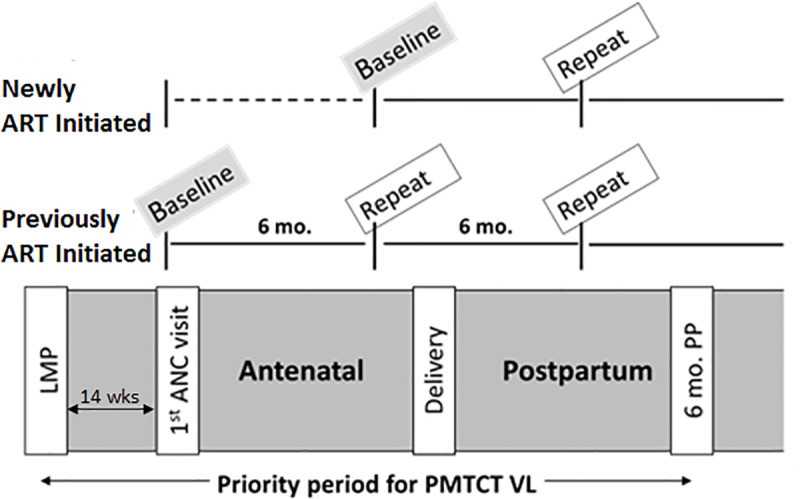
Optimal VL test sequences for HIV-positive pregnant women through 6 months postpartum.According to Kenya’s 2016 guidelines, pregnant women diagnosed with HIV in ANC are scheduled for baseline VL testing after 6 months on ART. Patients previously initiated on ART before conception are scheduled for baseline VL testing at first ANC visit. For virally suppressed patients in either category, the guidelines recommend repeat VL testing at 6 month intervals.